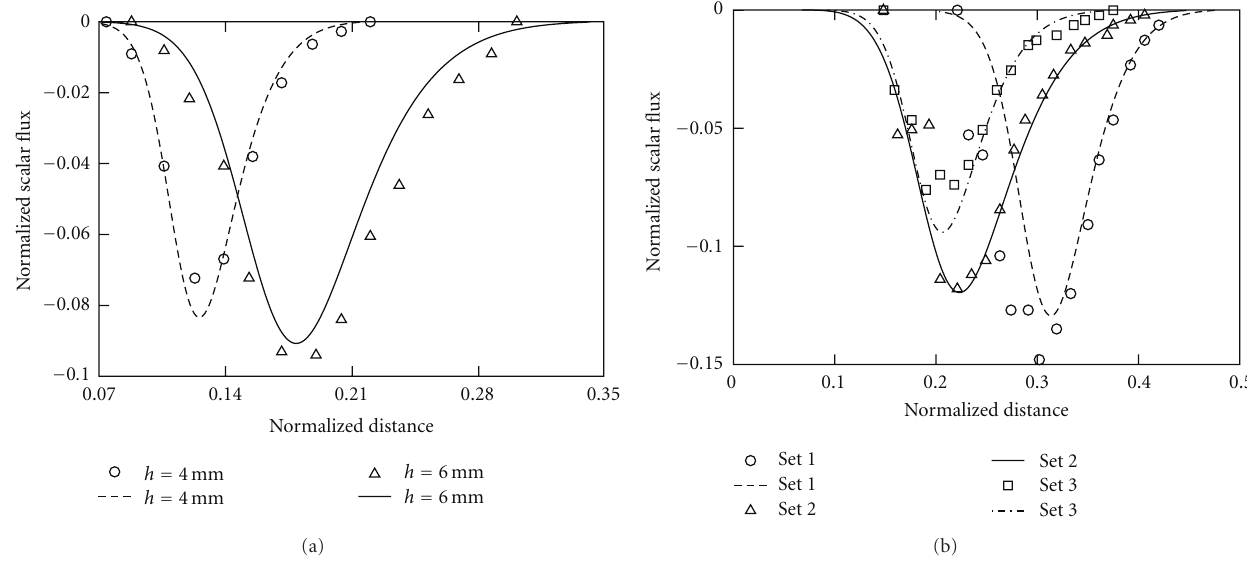
Figure 5: Axial profiles of the normalized axial turbulent scalar fluxes ρw (cid:5)(cid:5) c (cid:5)(cid:5) ( z ) in flames investigated by Li et al. [17] (a) and by Stevens et al. [18] (b). Symbols show experimental data. Curves have been computed.